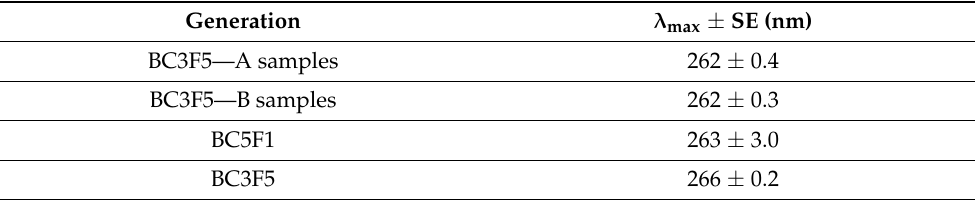
Table 3. Average λ max values ± SE in the 250–280 nm region of their absorbance spectra for the BC3F5 generation sampled by two methods, A and B, and for the BC5F1 and BC3F5 generation.